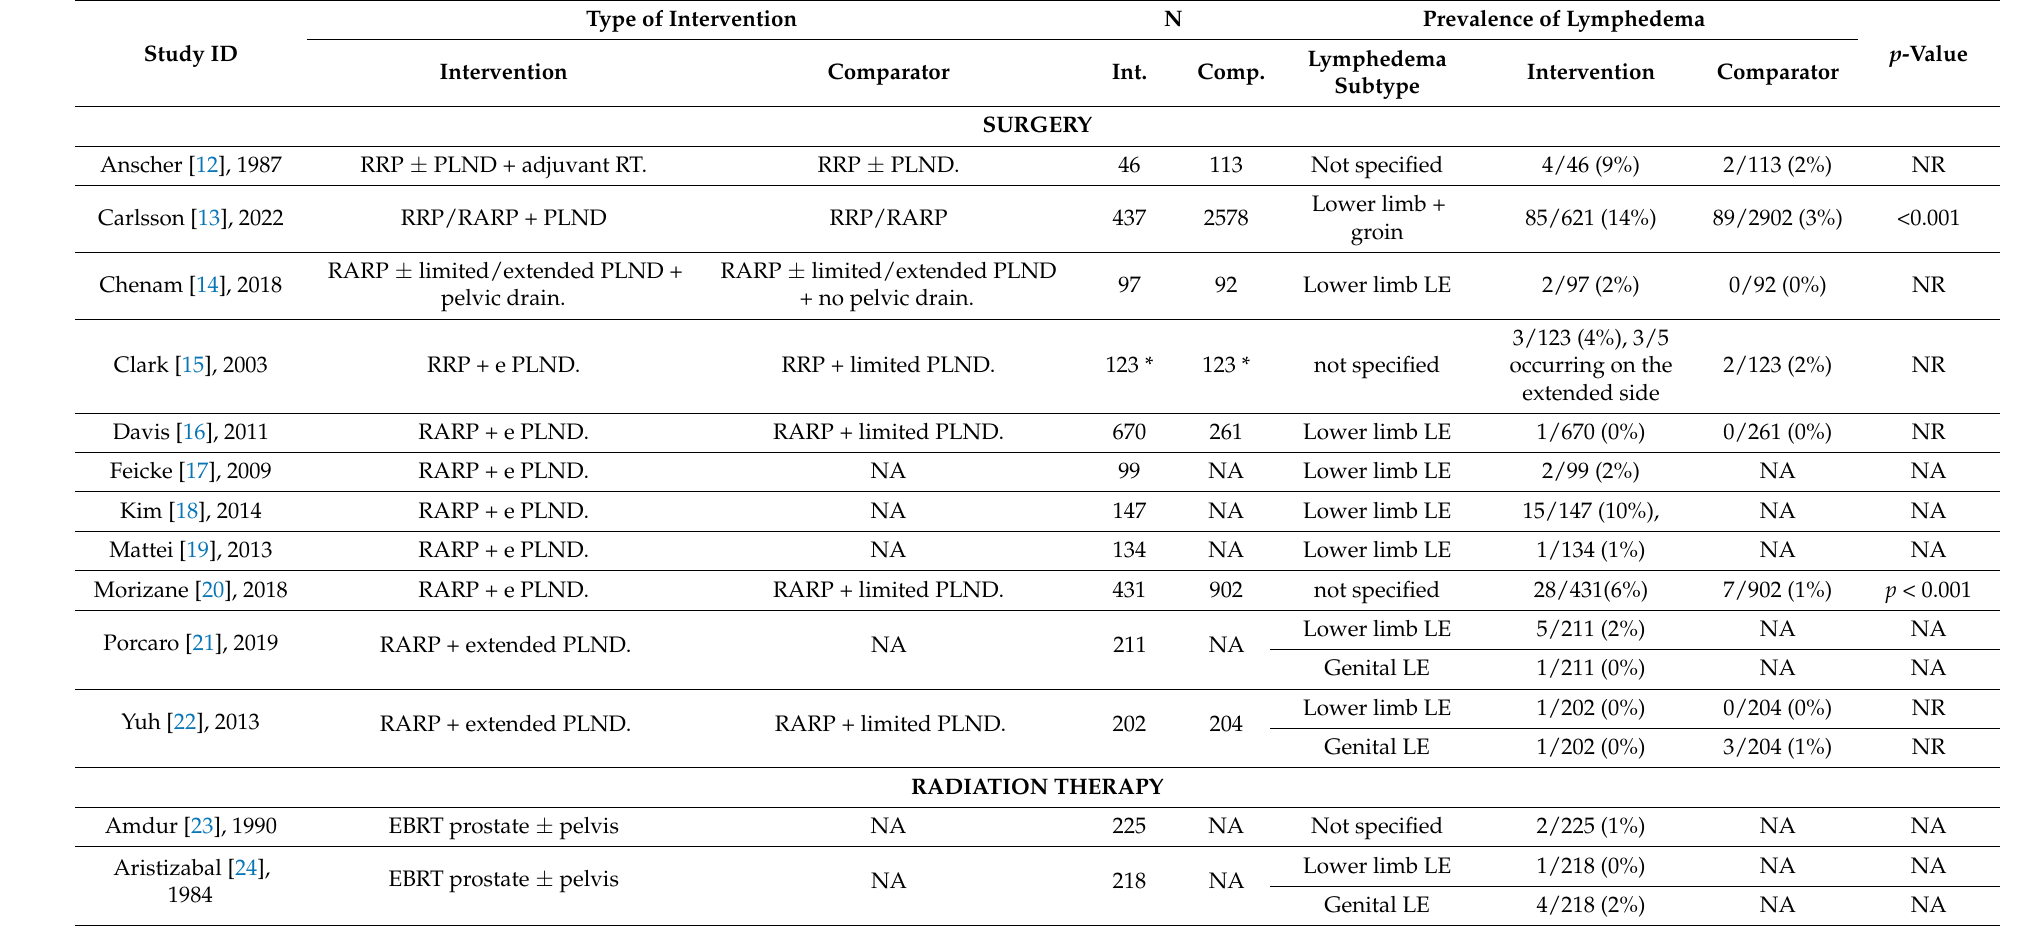
Table 2. Lymphedema rates of included